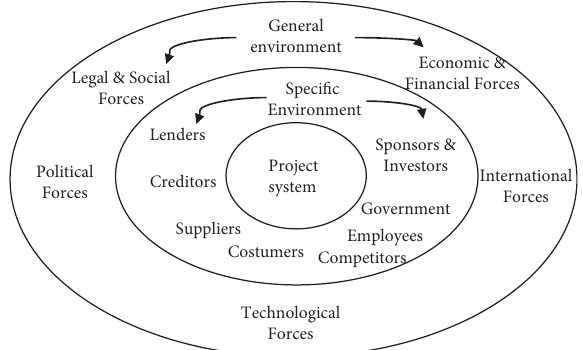
Figure 4: Analyze the business environment and make a rea- sonable